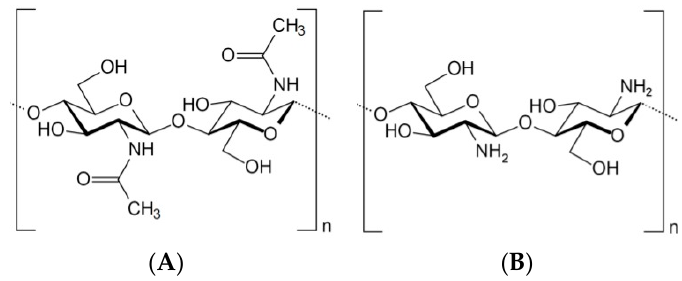
Figure 1. Chitin ( A ) and chitosan ( B ) chemical structure.